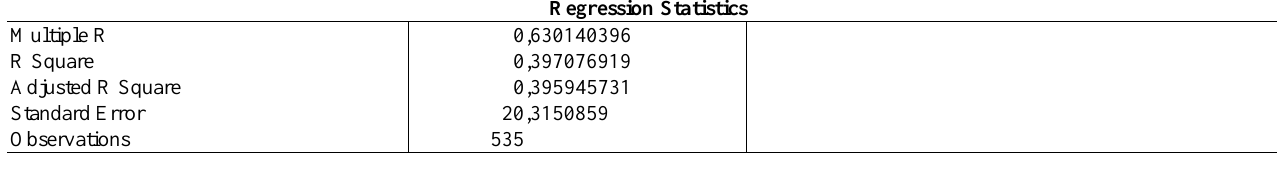
Table 11: Summary output of regression analysis between entrepreneurship and transformational leadership Regression